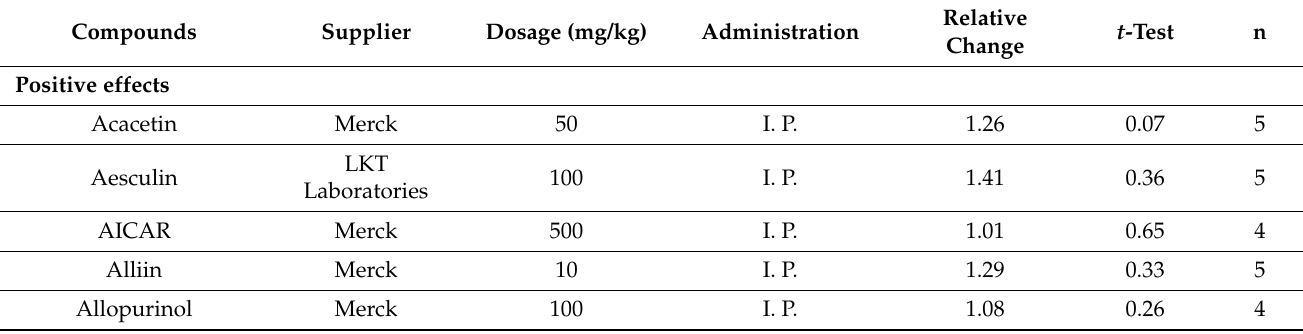
Table 1. Positive effects of compounds on the running activity of muscle- Sod2 -/-